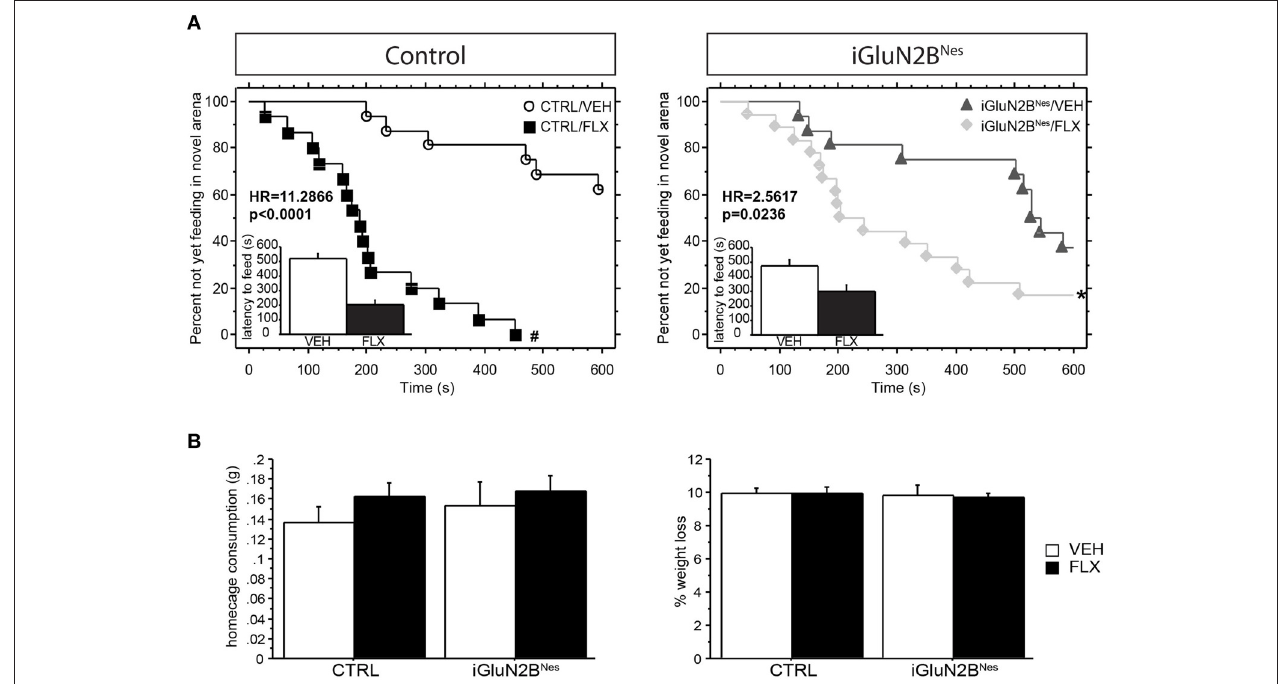
FIGURE 2 | Deletion of GluN2B attenuates the decrease in latency to feed in the NSF test after chronic FLX treatment. (A) Cumulative survival plots comparing CTRL mice (left) or iGluN2B Nes mice (right) treated with VEH or FLX. FLX significantly lowered the latency to feed in each group, with the greatest effect between treatment groups seen in CTRL mice. Insets show the average latency to feed in the novel arena, with those mice not feeding within the time limit of the test assigned a latency of 600s. (B) No significant difference was observed in home cage consumption (left) or % weight change (right) . HR, Hazard Ratio. * p < 0.05, # p <